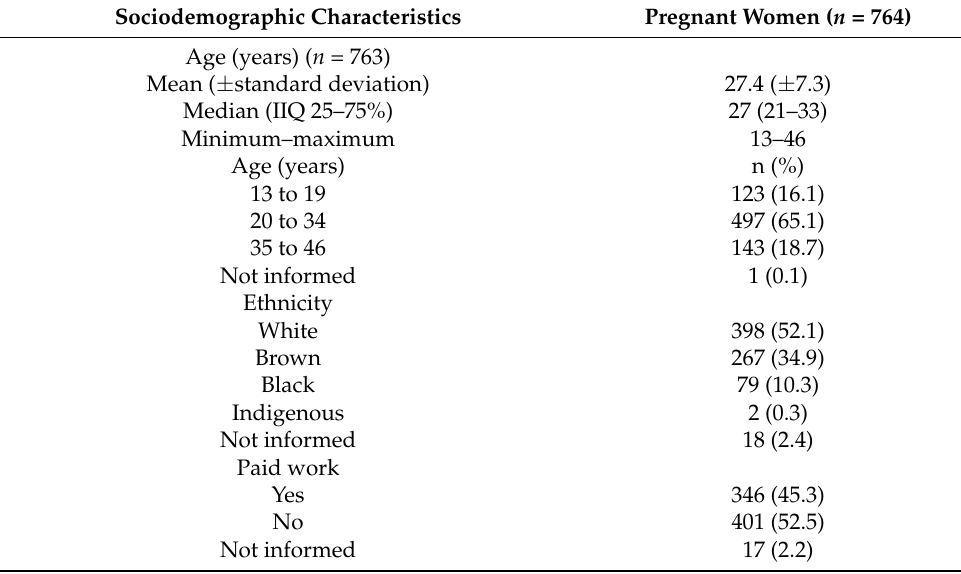
Table 1. Sociodemographic, clinical, and epidemiological data of the cohort high-risk pregnant women,